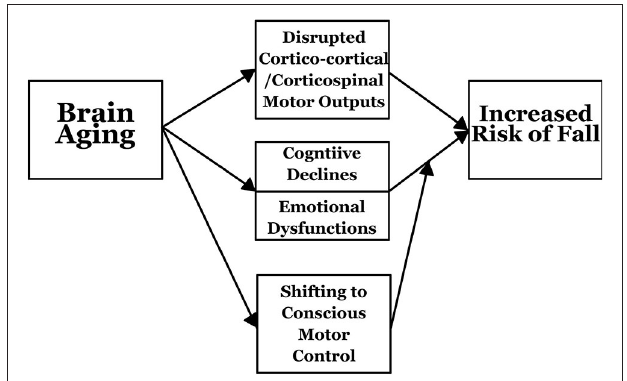
FIGURE 2 | An integrated framework of how brain aging increases risks of falling .